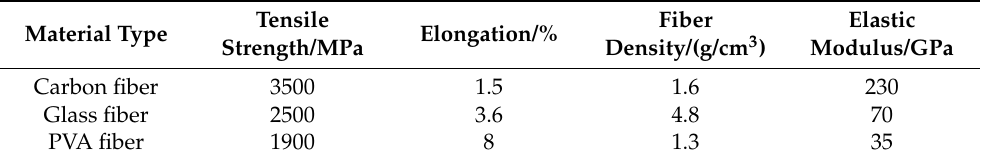
Figure 1. Test fibers: ( a ) PVA fiber; ( b ) Glass fiber; ( c ) Carbon fiber. Table 3. Fiber performance indicators.